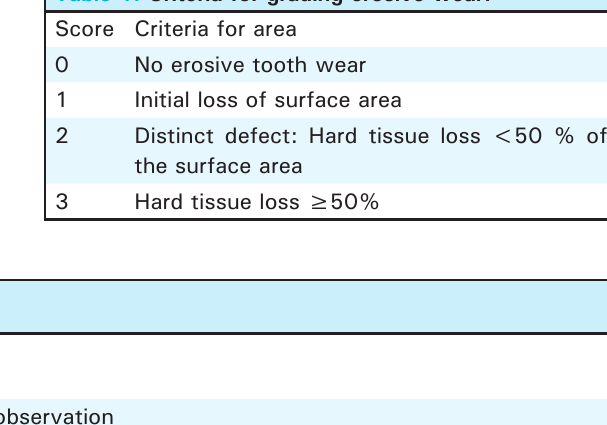
Table 1. Criteria for grading erosive wear.